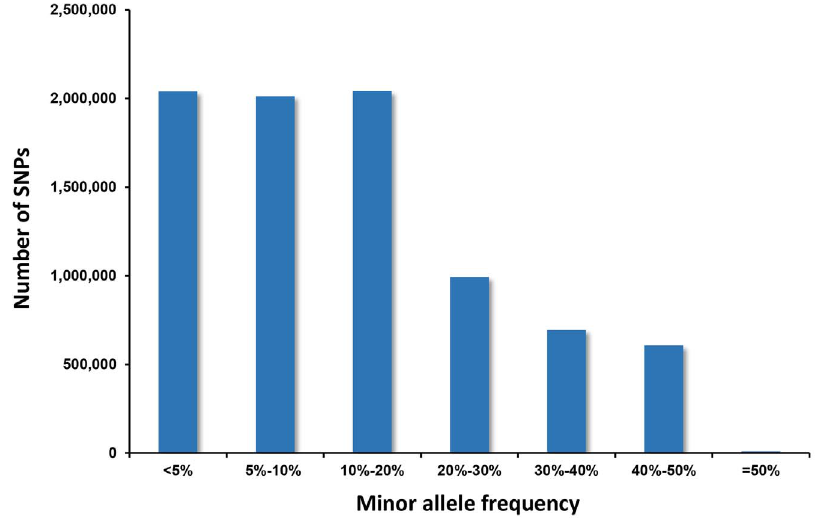
Figure 2. Distribution of SNP minor allele frequencies. SNPs were separated into six categories according to their MAF level. The first two categories contained the range of 5 percent and the other four categories contained the range of 10